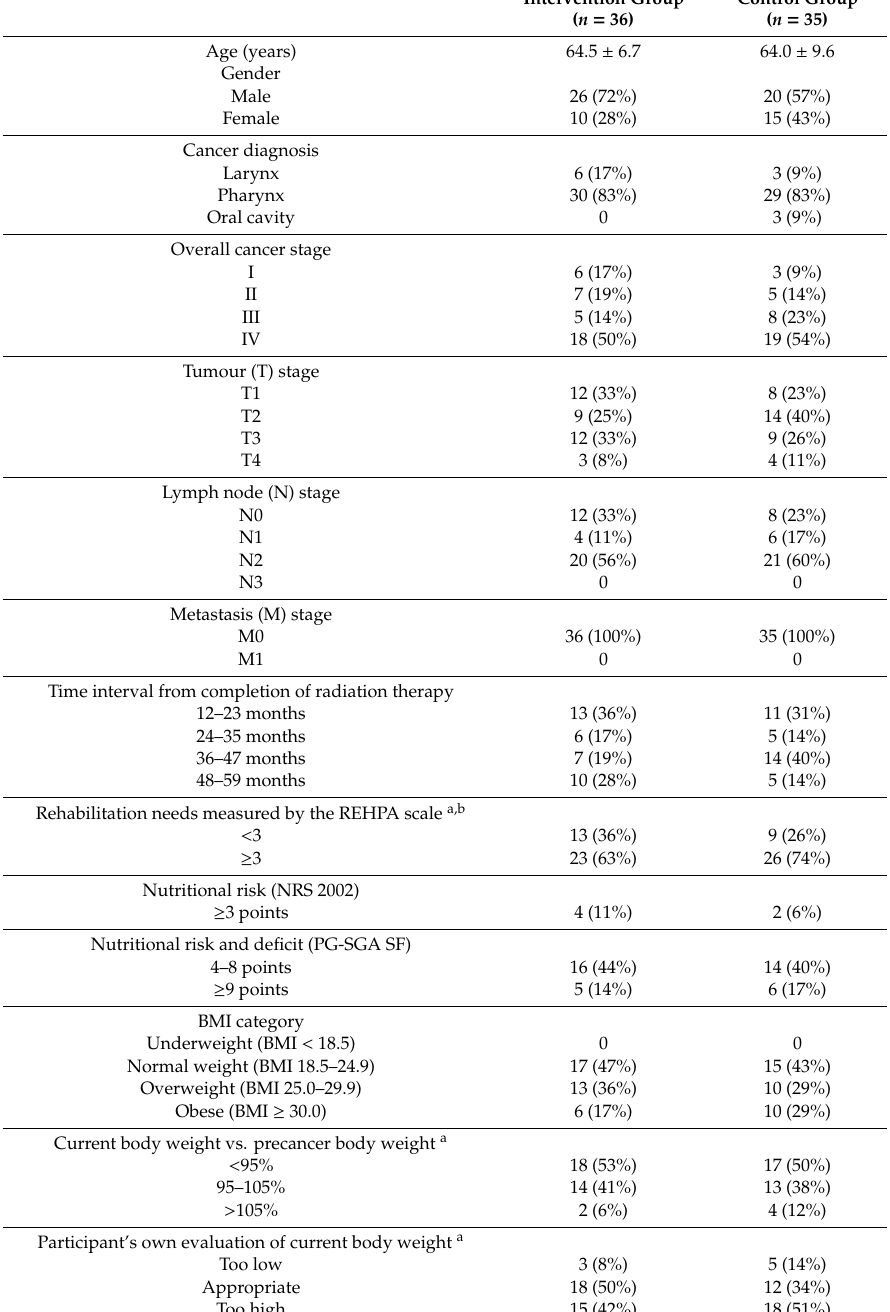
Table 2. Baseline characteristics of participants in the NUTRI-HAB